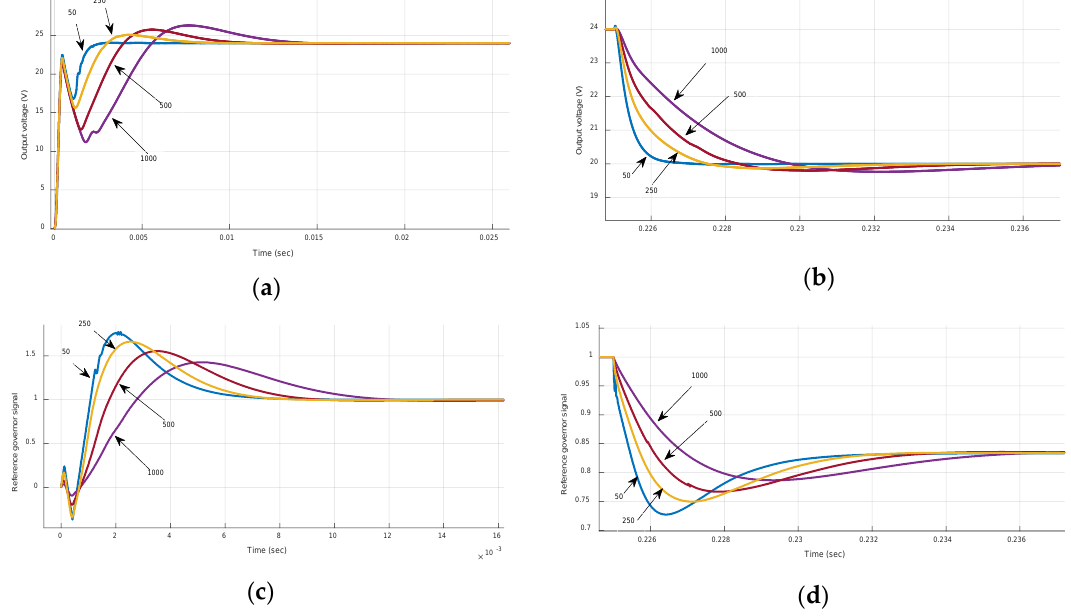
Figure 8. Effect of control weighting factor r w (50, 250, 500, 1000) corresponding to cases Figure 1a,b. ( a ) Startup transient response for tracking a reference input of 24 V with an input voltage Vin = 12 V; ( b ) reference input changes from 24 V to 20 V; ( c ) reference governor signal of case ( a ); ( d ) reference governor signal of case ( b ).